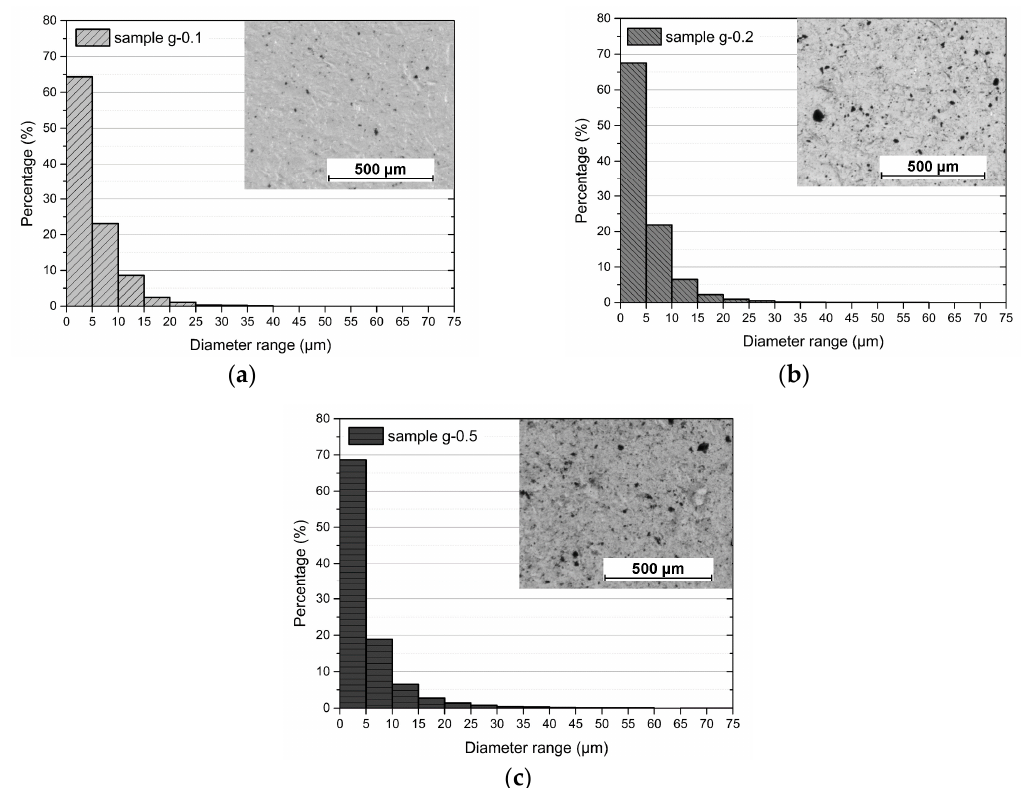
Figure 3. Dimensional distribution of the flakes inside the coatings, with relative stereomicroscope observation (in the inset). ( a ) sample g-0.1; ( b ) sample g-0.2; ( c ) sample g-0.5.